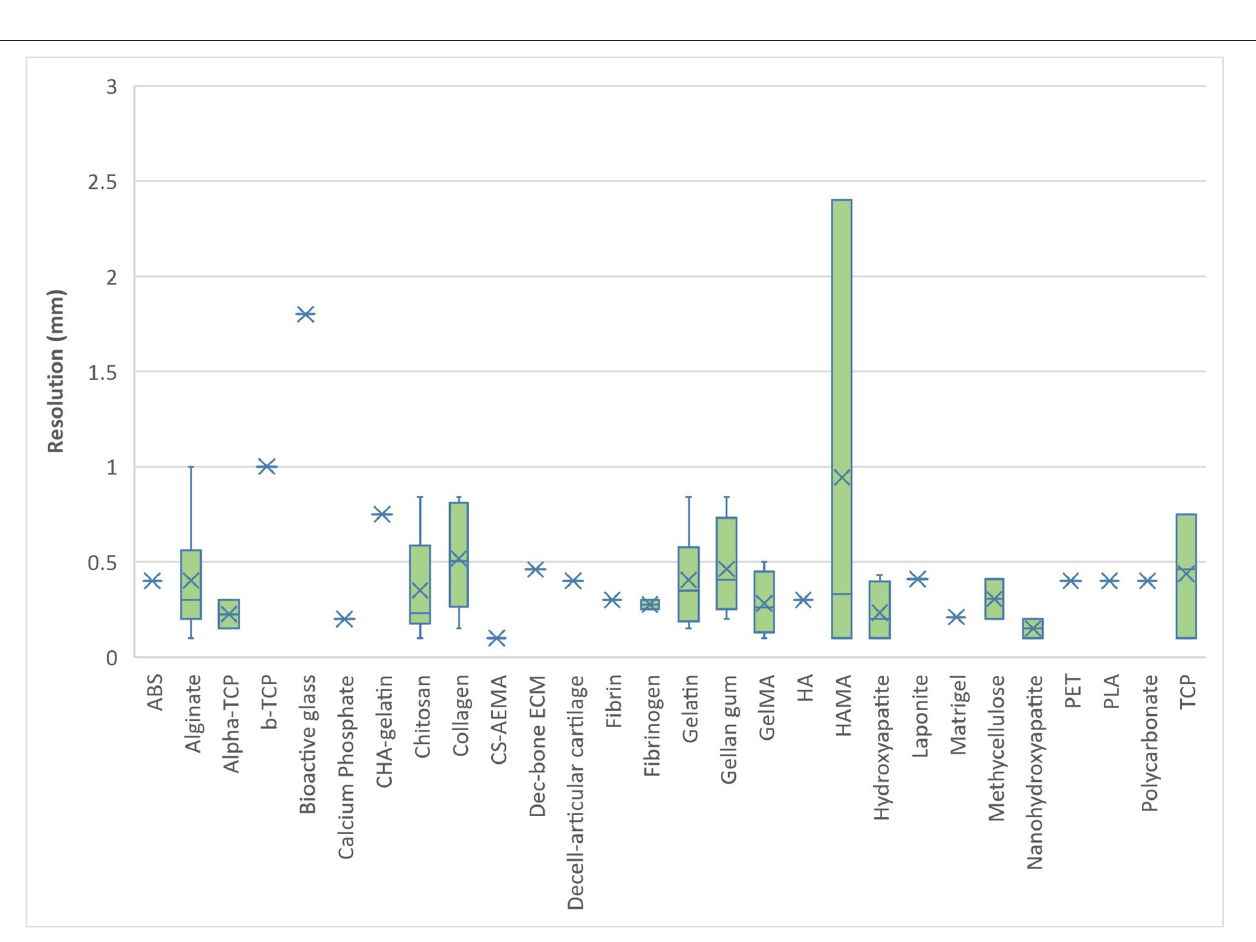
FIGURE 5 | Bioprinting resolution for natural-derived